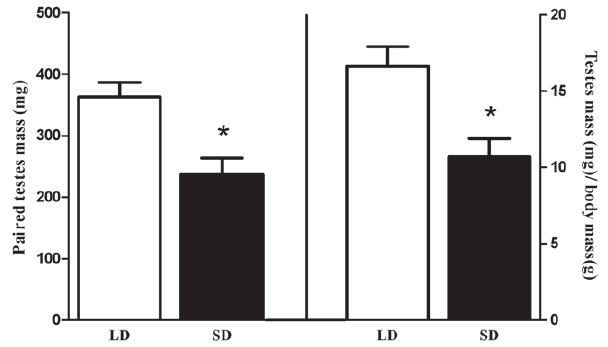
Figure 1. Reproductive responses to photoperiod. Exposure to short day lengths for 10–15 weeks reduced absolute paired testes mass (left) and paired testes mass controlling for body mass differences (right). * p # 0.05.